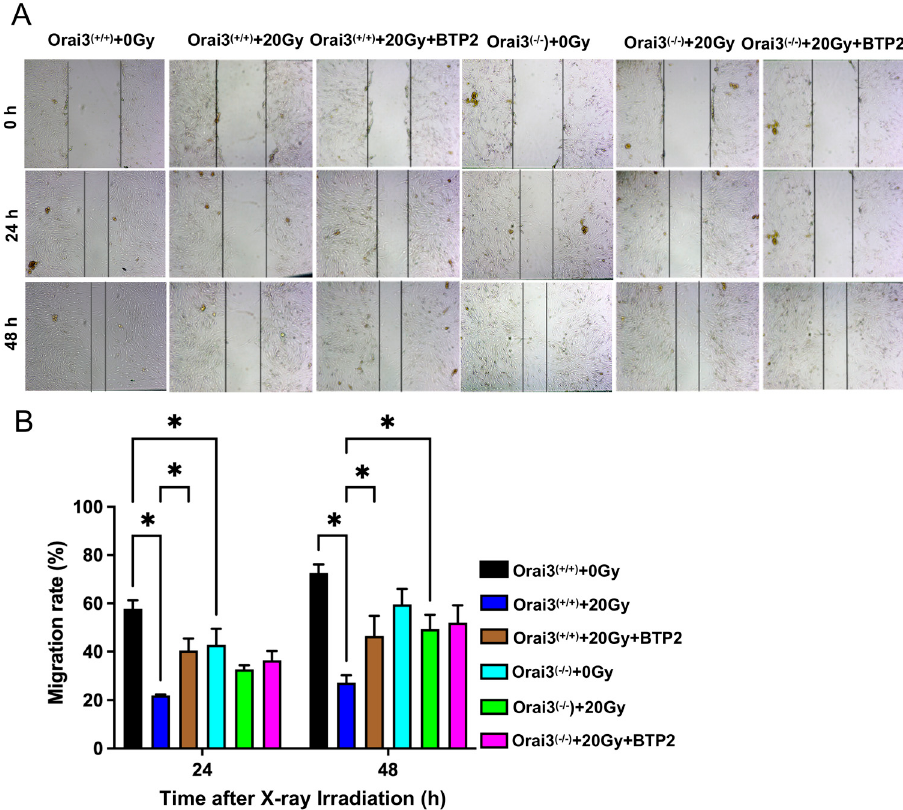
Figure 4. Role of Orai3 in X-ray irradiation-induced inhibition of cell migration in rat brain microvascular endothelial cells (rBMECs). ( A , B ) Representative images ( A ) and summary data ( B ) showing cell migration 24 h and 48 h after irradiation for rBMECs derived from wild-type rats (Orai3 (+/+) ) and unexposed (0 Gy) or exposed (20 Gy) to X-ray irradiation and untreated or treated with BTP2 (5 µM); and rBMECs derived from Orai3 knockout rats (Orai3 ( − / − ) ) unexposed (0 Gy) or exposed to X ‒ ray irradiation (20 Gy) and untreated or treated with BTP2 (5 µM). Data are shown as the mean ± SEM ( n = 3), * p < 0.05 analyzed by two ‒ way analysis of variance followed by Dunne tt ’s multiple comparisons test.